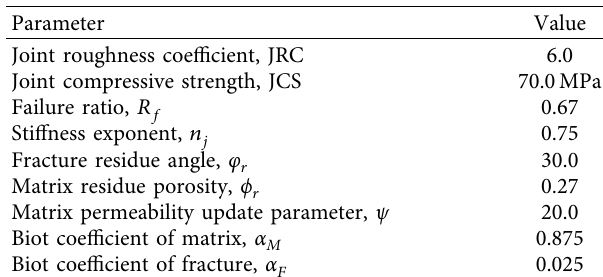
Figure 10: Geomechanical configuration. Table 2: Mechanical parameters.